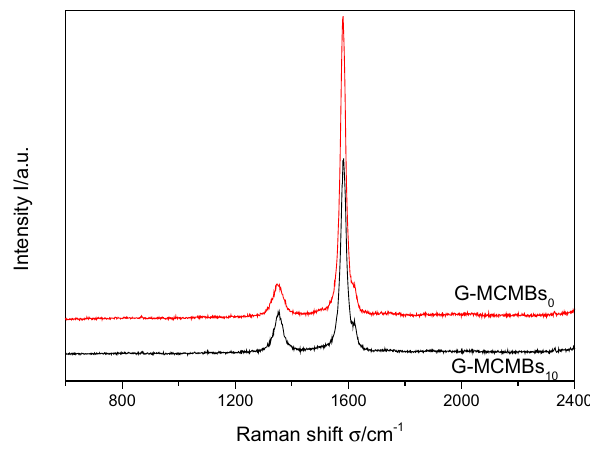
Fig. 10 Raman Spectra of graphitized MCMBs 0 and MCMBs